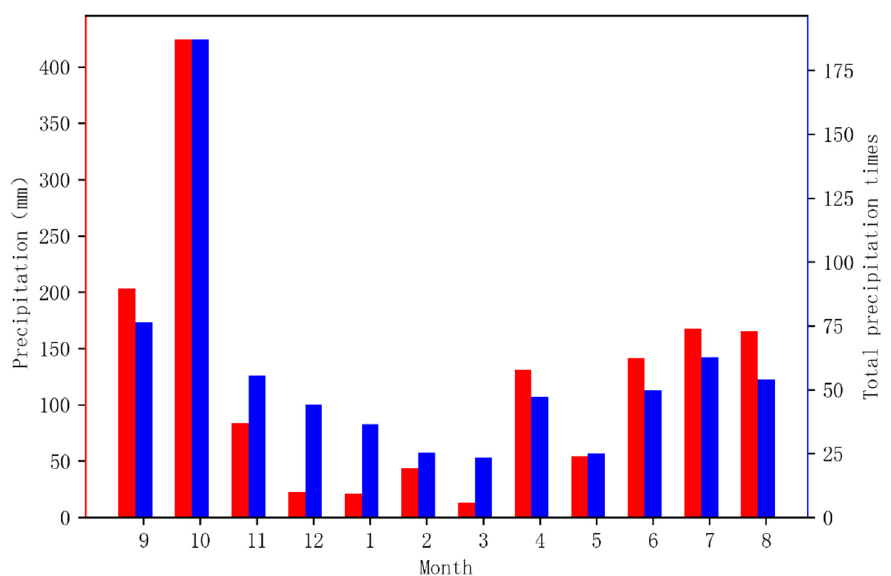
Figure 5. Total monthly precipitation and total monthly precipitation hours in Hainan Province, from September 2020 to August 2021.